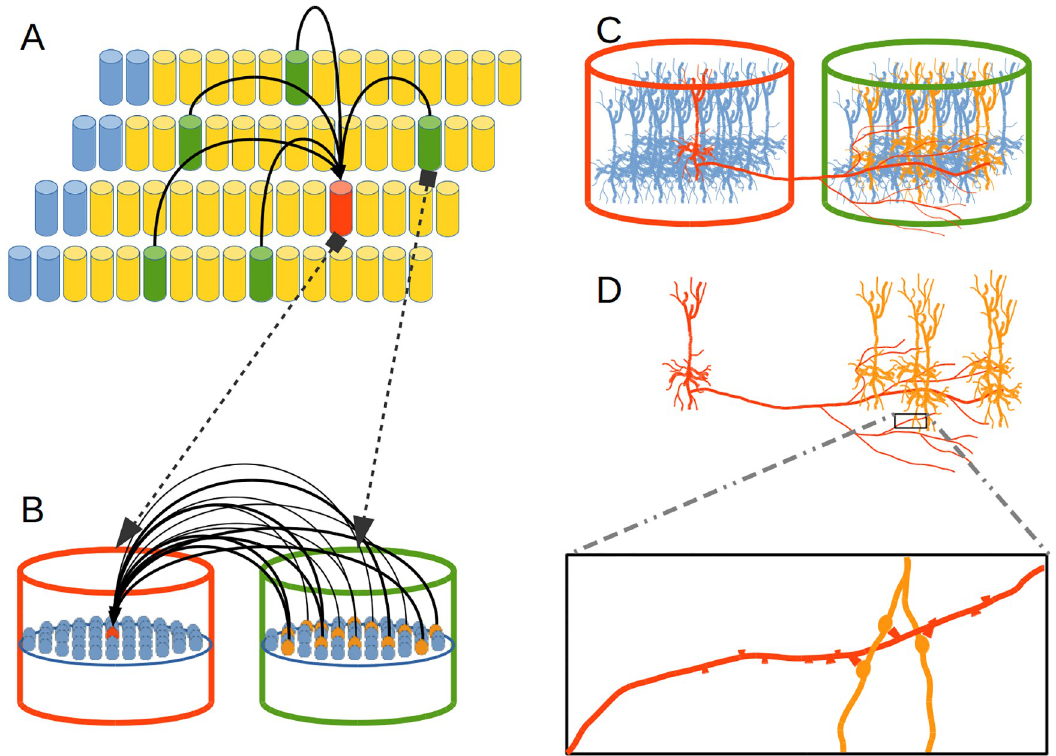
Fig 6. Distal dendrite connections. (A) Distal dendritic branches from neighboring CCs inside the receptive field of a CC in the EL. A distal dendritic branch between the red CC and a green CC means that every neural unit in the red CC is linked with a different subset of neural units in the green CC by means of potential connections. (B) Potential connections in a dendritic branch which link a neural unit in the red CC with a subset of neural units in a green CC. The subset of potential connections comes from a percentage of neural units inside the green CC. Such percentage is a tunable parameter for the CC. (C) A distal dendritic branch between a pyramidal cell in a CC and a sub-set of pyramidal cells in a neighboring CC inside its receptive field in the EL. (D) Physical proximity of a dendritic branch from the red cell to axonal branches from yellow cells constitutes potential connections which could prosper becoming in established synapses depending on the sequential activity among cells.